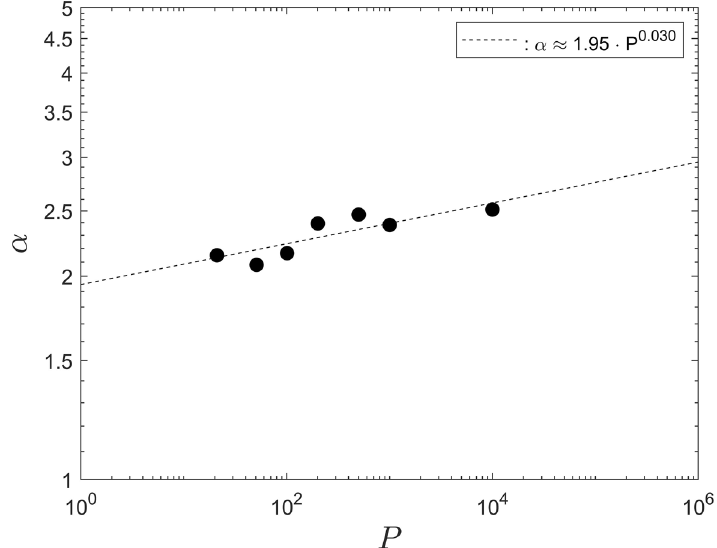
Figure 9. The parameter α as a function of the population size P .